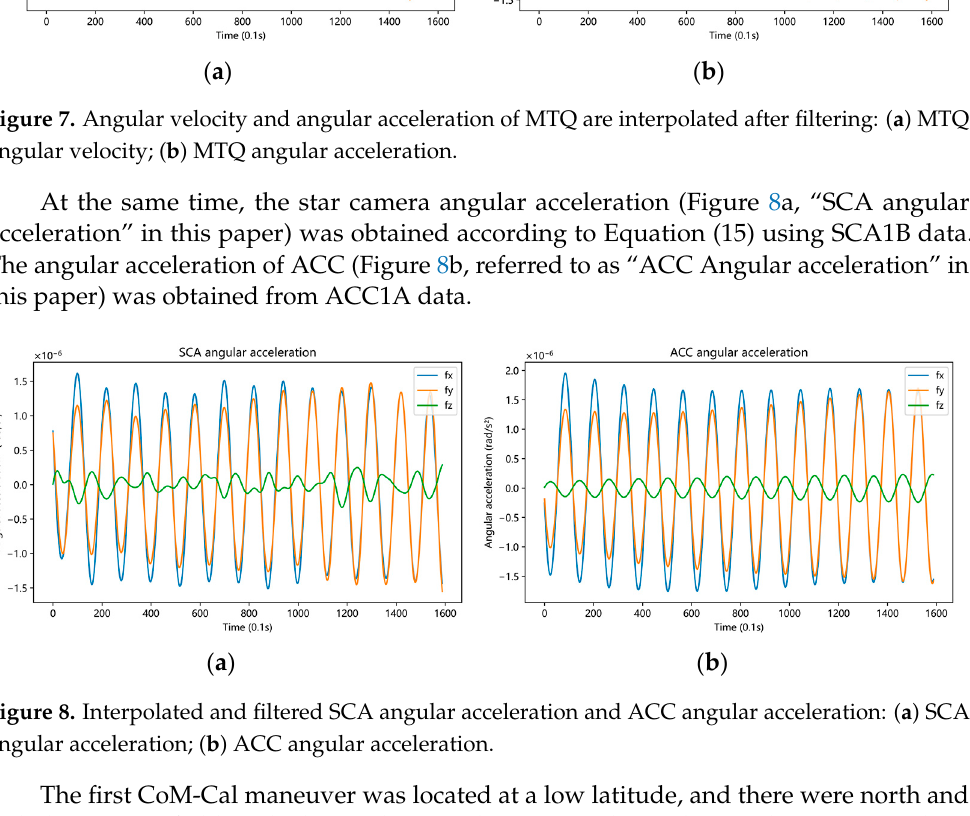
Figure 8. Interpolated and filtered SCA angular acceleration and ACC angular acceleration: ( a ) SCA angular acceleration; ( b ) ACC angular acceleration.